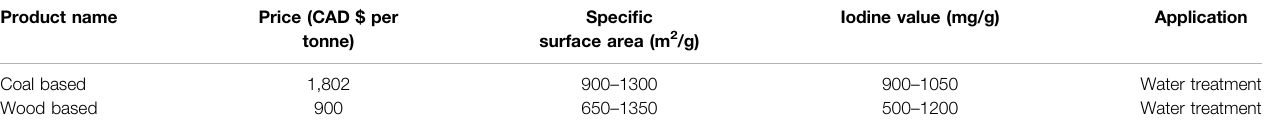
TABLE 8 | Comparison of activated carbon coal based and biomass based, respectively (adapted from (Chemical Auxiliary Agent). Product